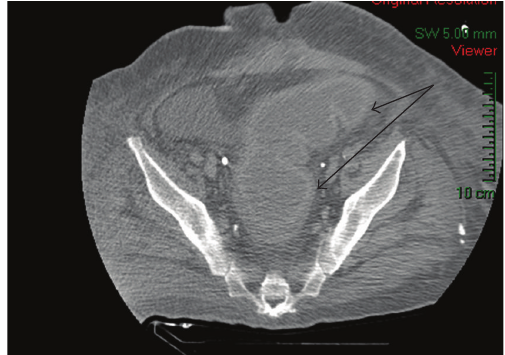
Figure 1: CT abdomen of a patient with Clostridium di ffi cile colitis. The image shows dilated descending loop with thickening of wall (see black